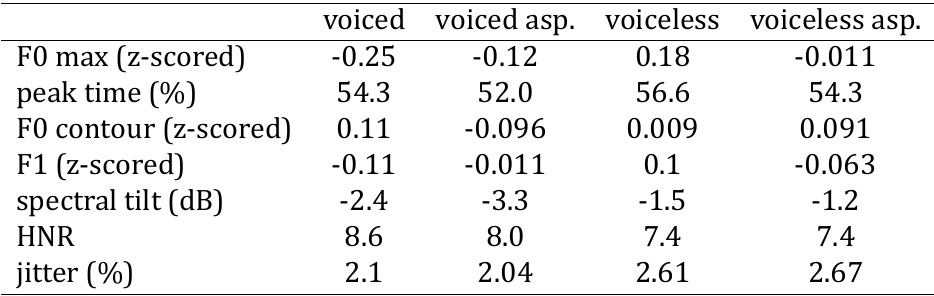
Table 12: Telugu acoustic measures by following stop